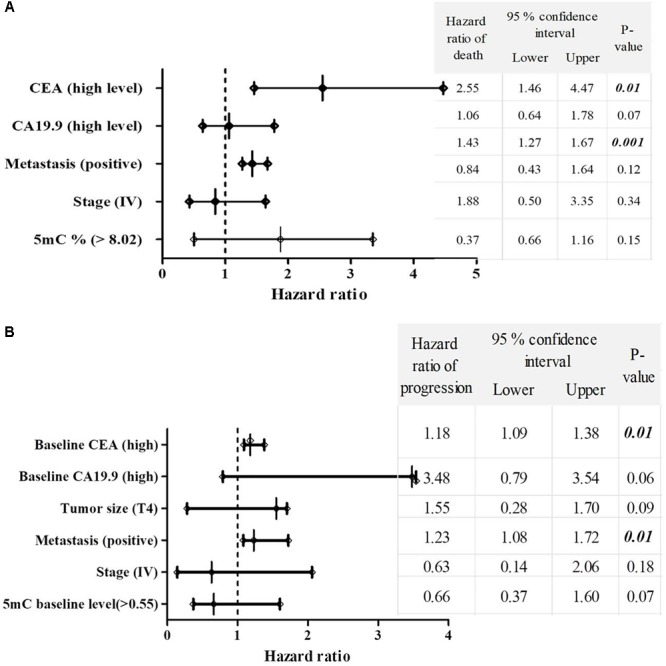
The multivariate COX regression hazard model. (A) Hazard ratio of death and (B) progression. Table indicates the hazard ratio and 95% confidence interval, associated with high level of CEA, high level of CA19.9, T4, positive metastasis, stage (IV) and 5mc level > 0.55. P-value < 0.05 is a significant hazard of death or progression, when hazard ratios of table variables compared with reference variables. Reference variables (hazard value of 1): low level of CEA, low level of CA19.9, T2 and T3 tumors, negative metastasis, stages II and III and 5mC level ≤ 0.55. OS, overall survival; EFS, event free survival; CEA, carcinoembyonic antigen; CA19.9, carbohydrate antigen 19.9; 5mC, 5, methoxy 2 deoxy cytosine.